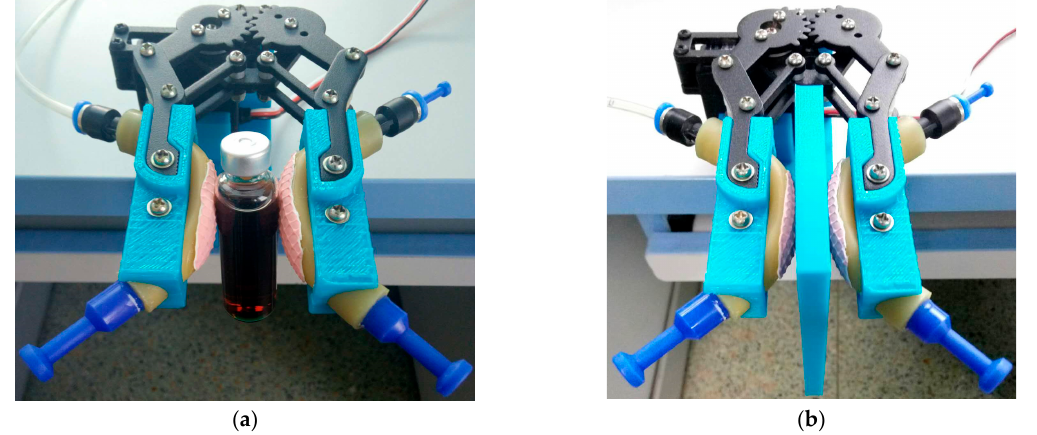
Figure 11. The experiment setup of sensing slippage. ( a ) clamping an object with smooth surface; ( b ) clamping an object with rough surface.